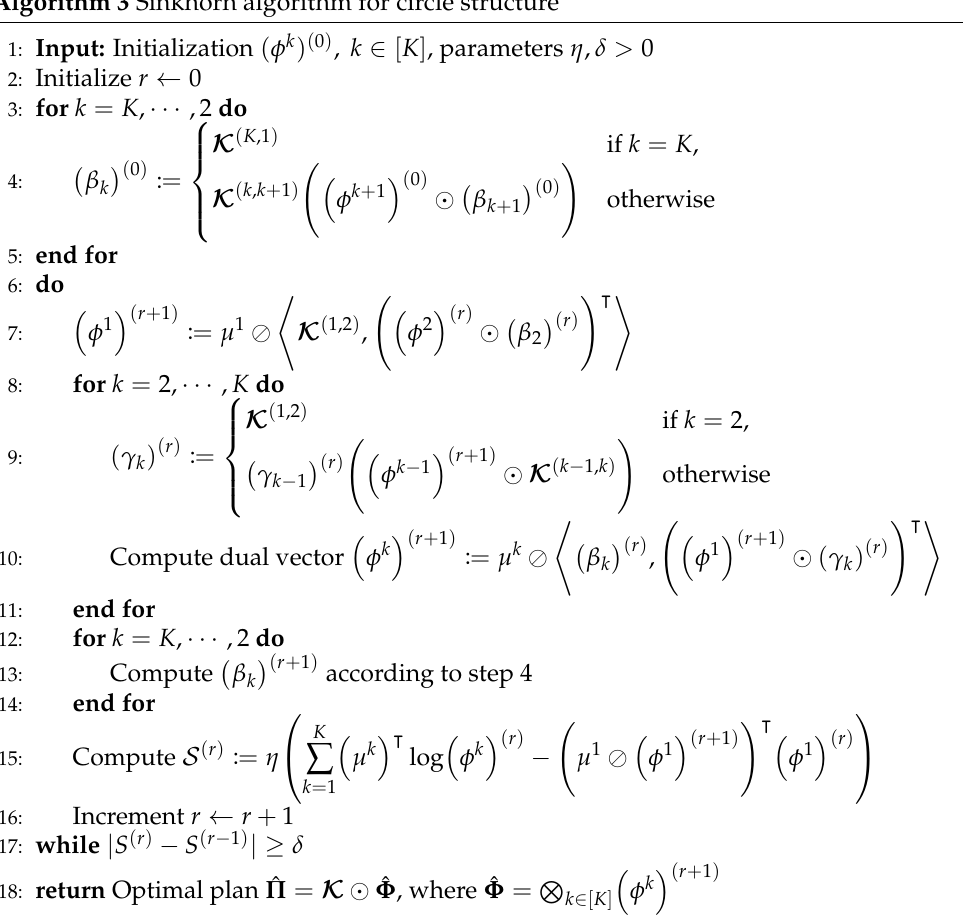
Algorithm 3 Sinkhorn algorithm for circle